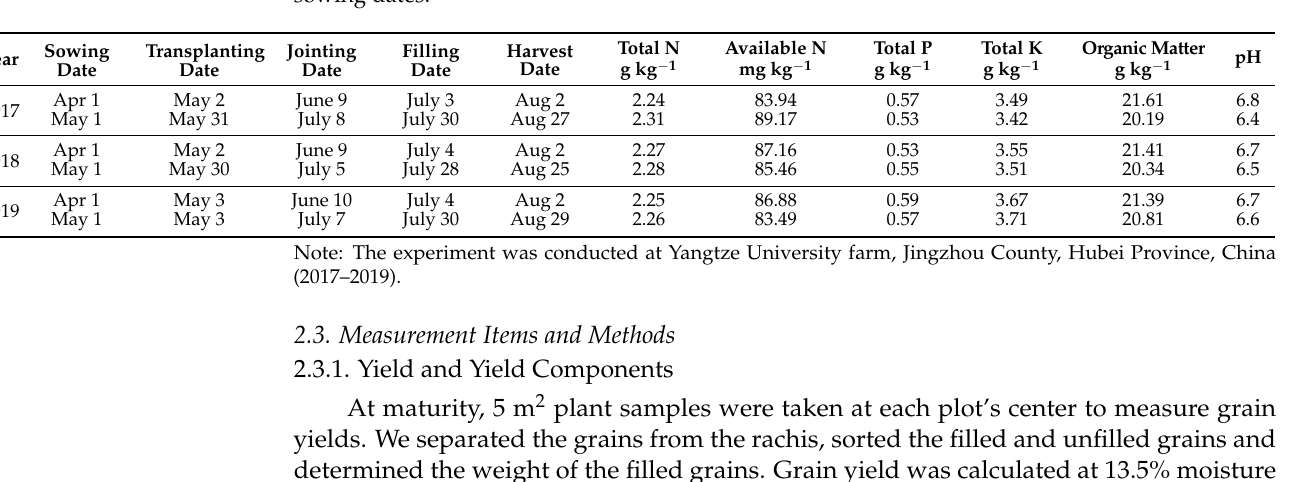
Figure 2. Meteorological data in 2017 – 2019. Note: Tmax, Tmin, Tmean and Pre represent maximum temperature, lowest temperature, average temperature and precipitation, respectively. Table 1. Growth stage and soil characteristics’ average values ( n = 3) of experimental field for two sowing dates.